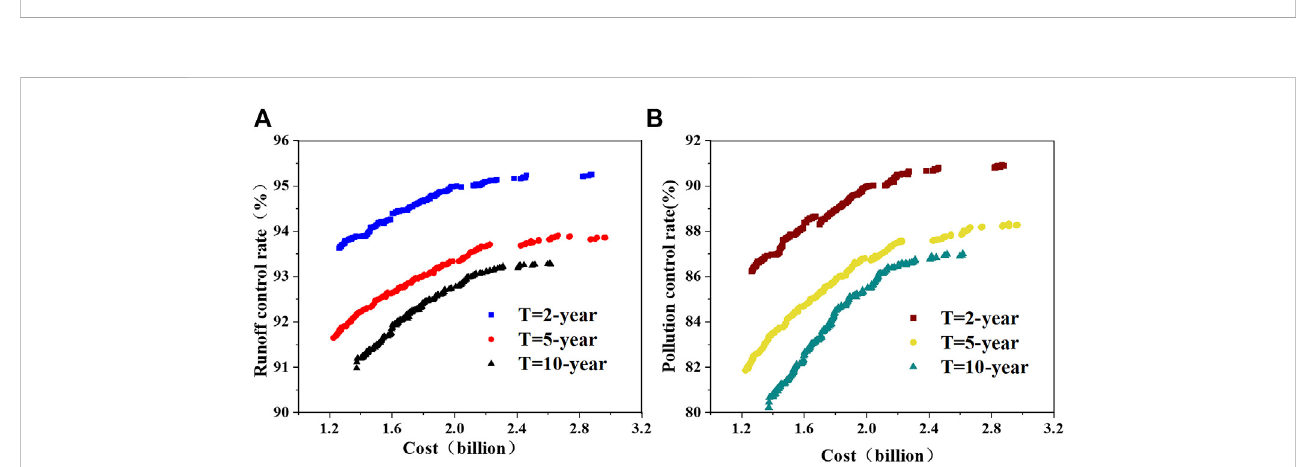
FIGURE 10 Runoff control rate and pollutant control rate under different investments conditions.